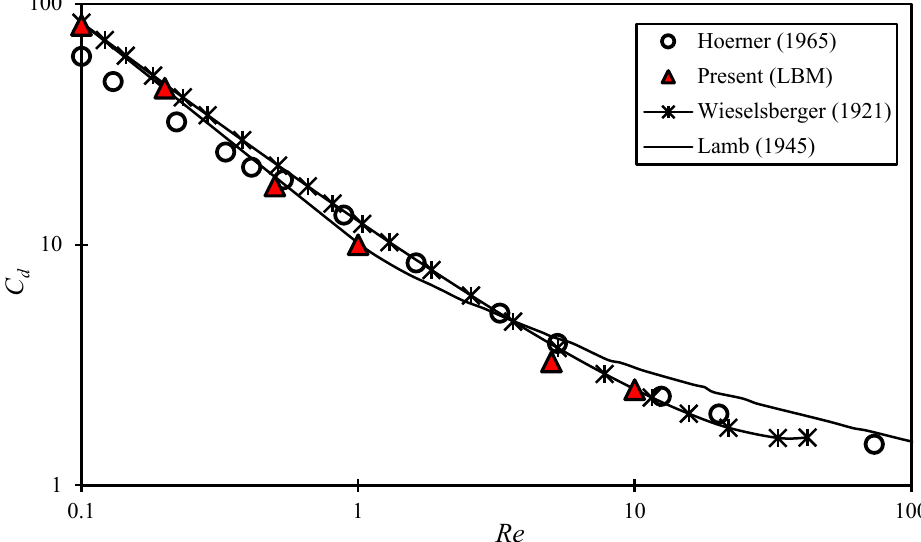
Figure 5. Comparison of current IB-LBM model data with the reported experimental results in refs. [48–50].